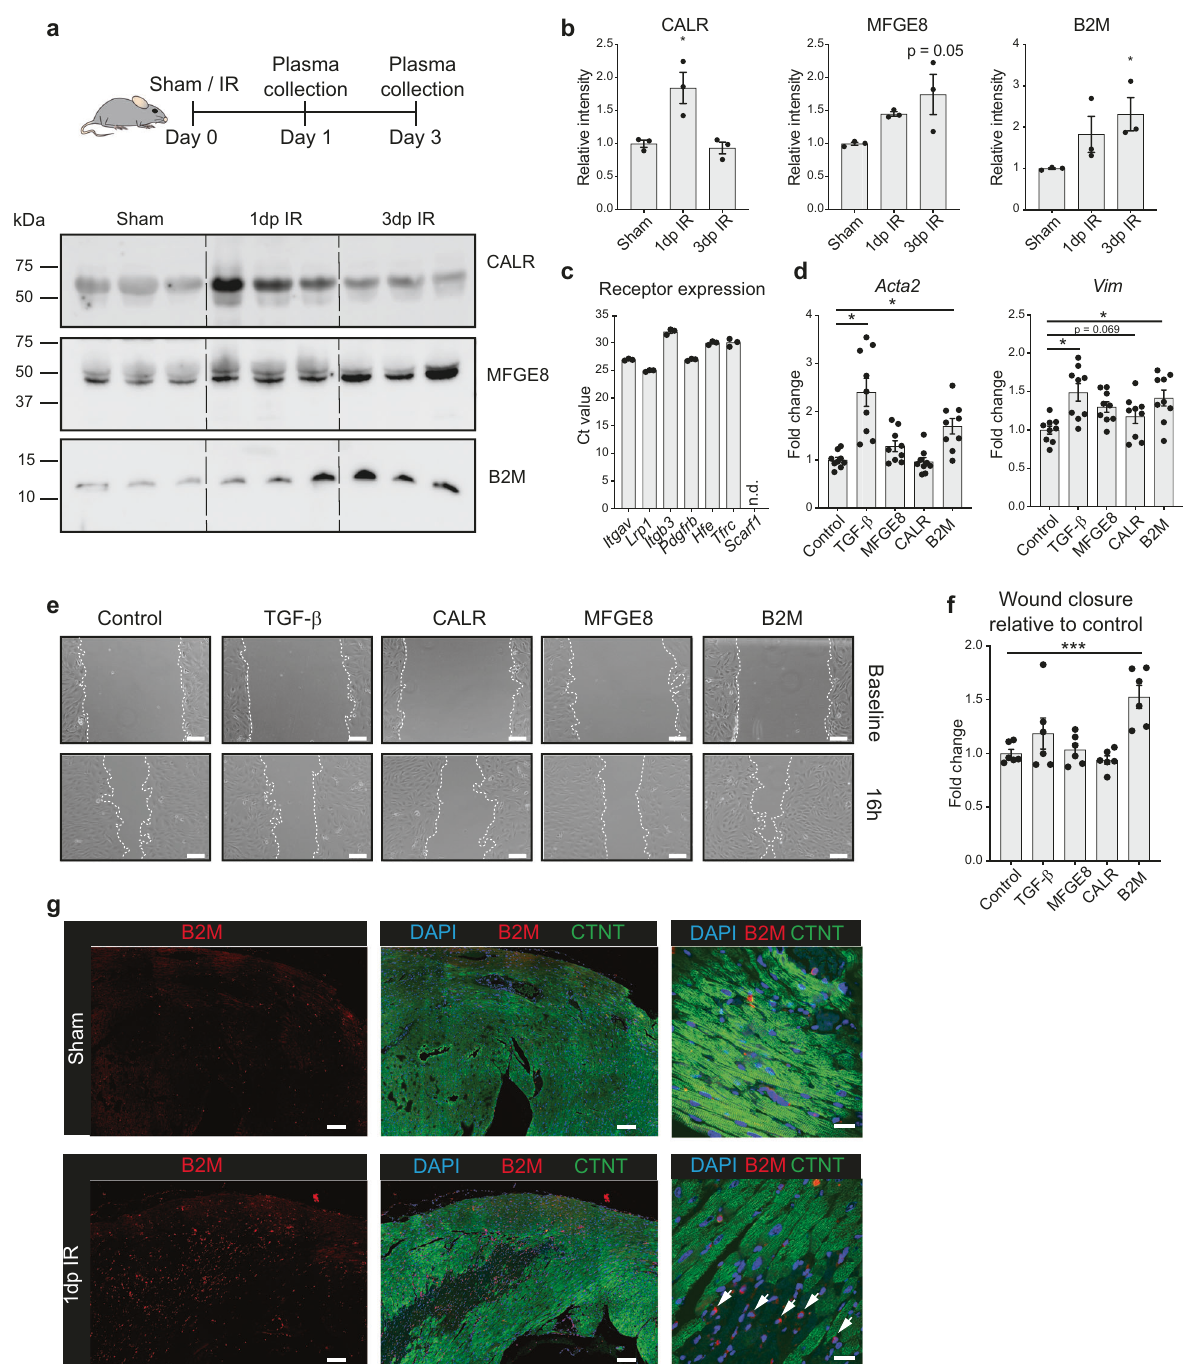
Fig. 6 B2M is secreted by stressed cardiomyocytes to activate fi broblasts. a Western blot on mice plasma at different time points post IR or 1 day post sham ( n = 3 animals). Equal loading of plasma proteins was con fi rmed by Coomassie staining (Supplementary Fig. 9). b Quanti fi cation of immunoblots in ( a ); * P < 0.05 compared to sham, Kruskal – Wallis test with Dunnett ’ s multiple comparison post-hoc test. c Cognate receptor expression of selected ligands in NIH/3T3 fi broblasts is shown by RT-qPCR. d Upregulation of two myo fi broblast ( Acta2 and Vim ) markers in NIH/3T3 cells after treatment with B2M, TGF- β served as positive control ( n = 9 from 3 independent experiments). e Increased wound healing of NIH/3T3 cells after treatment with B2M, assessed by scratch assay. Images show representative pictures for each condition. Dashed lines indicate gap size. f Quanti fi cation of wound healing assay relative to corresponding control ( n = 6 from 2 independent experiments). Scale bars, 200 μ m. g Immunohistochemistry images of heart slices after IR or sham surgery. White arrows indicate cardiomyocytes (larger cells with diminished CTNT staining) within the infarct zone that show B2M expression. CTNT cardiac troponin T. Scale bars, 100 μ m (left and middle panels) and 20 μ m (right panels). Data are presented as mean ± SEM. * P < 0.05, *** P < 0.001. One-way ANOVA with multiple comparison vs control and Dunnett ’ s adjustment for multiple hypothesis